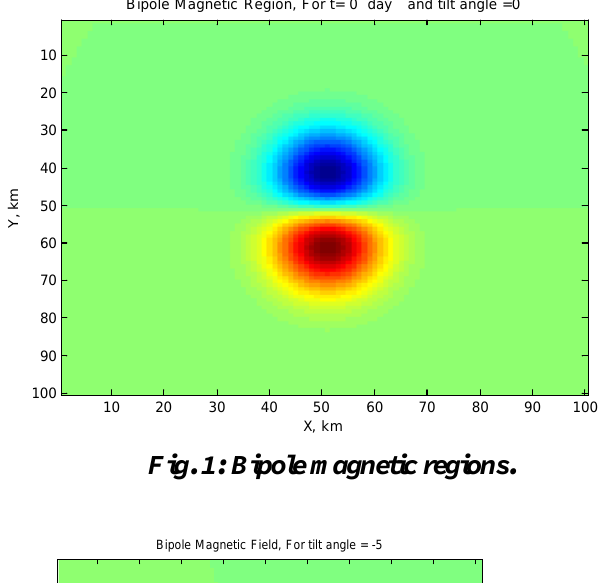
Bipole Magnetic Region, For t= 0 day and tilt angle =0